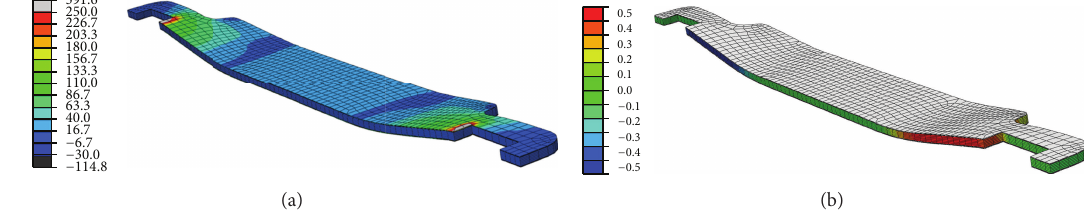
Figure 15: Simulation results for the longboard under normal service loads: (a) principal stress value; (b) shear stress distribution.